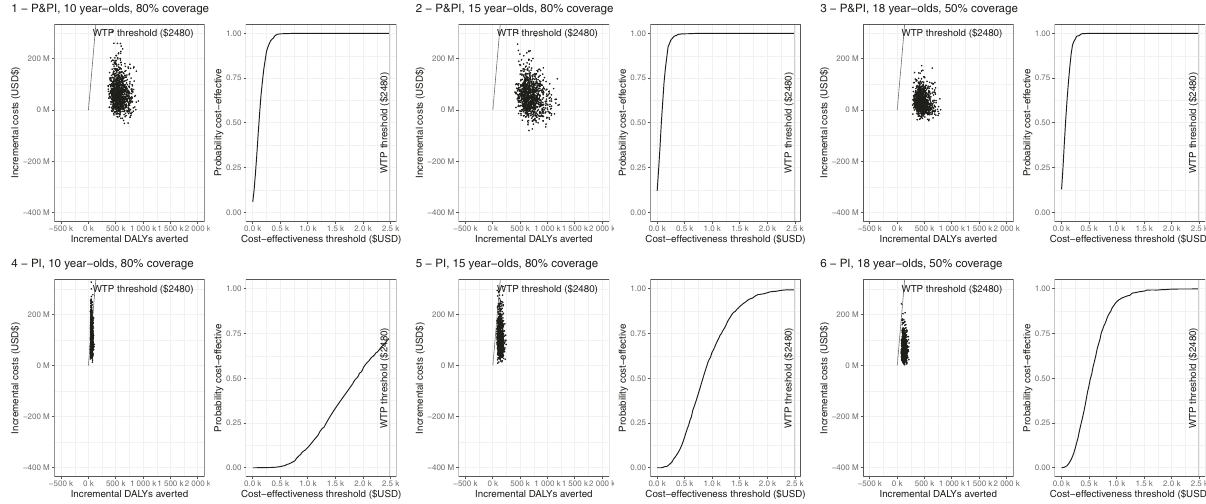
Fig. 1 Cost effectiveness planes and cost-effectiveness acceptability curves for vaccination scenarios in South Africa. Top row (panels 1 – 3) shows cost- effectiveness planes (scatter plot) and cost-effectiveness acceptability curves (line graph) for three scenarios with pre- and post-infection vaccine ef fi cacy. Bottom row (panels 4 – 6) shows cost-effectiveness planes and cost-effectiveness acceptability curves for three scenarios of post-infection-only vaccine ef fi cacy. P&PI denotes vaccine with pre- and post-infection. PI denotes vaccine with post-infection ef fi cacy only. DALY disability-adjusted life year, USD United States Dollars, WTP willingness to pay.